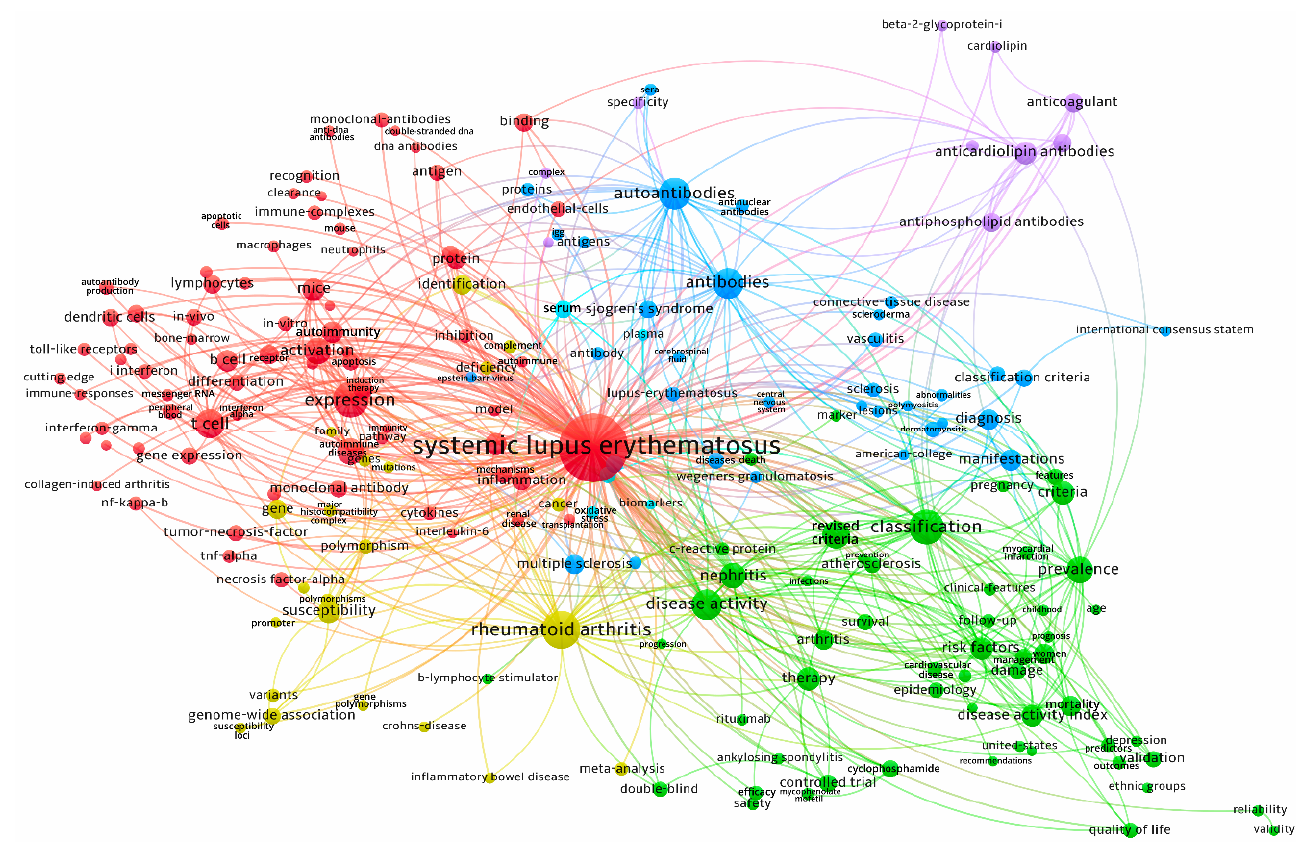
Figure 7. A co-occurrence network of “Keywords Plus” from original articles on systemic lupus erythematosus from 2001 to 2020.